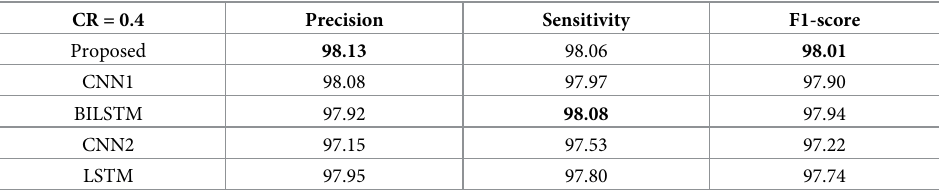
Table 7. Average precision, sensitivity and F1-score of each classification network at CR = 0.4. CR = 0.4